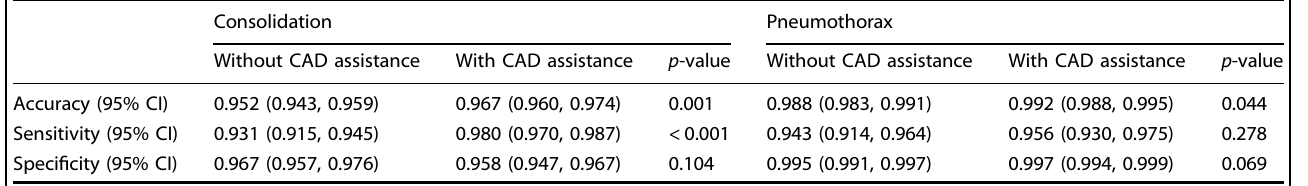
Table 4. Pooled accuracy, sensitivity, and speci fi city of six readers with and without the CAD assistance. Consolidation